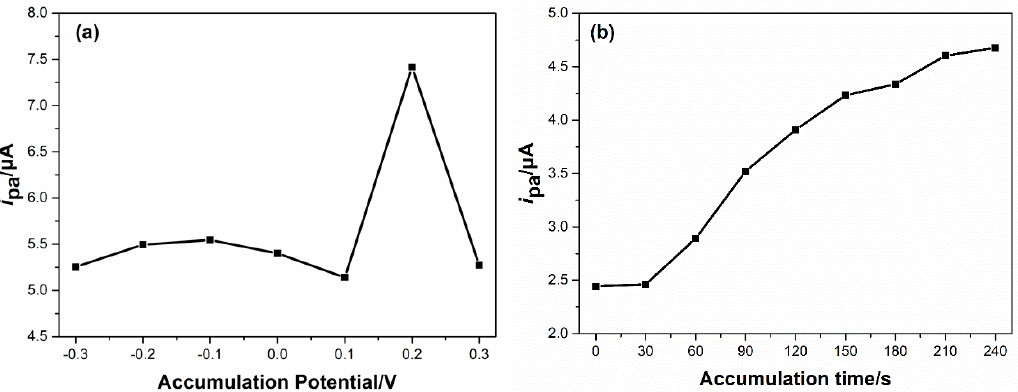
Figure 7. Effect of accumulation potential ( a ) and accumulation time ( b ) on the anodic peak currents of 10 μ M Trp.